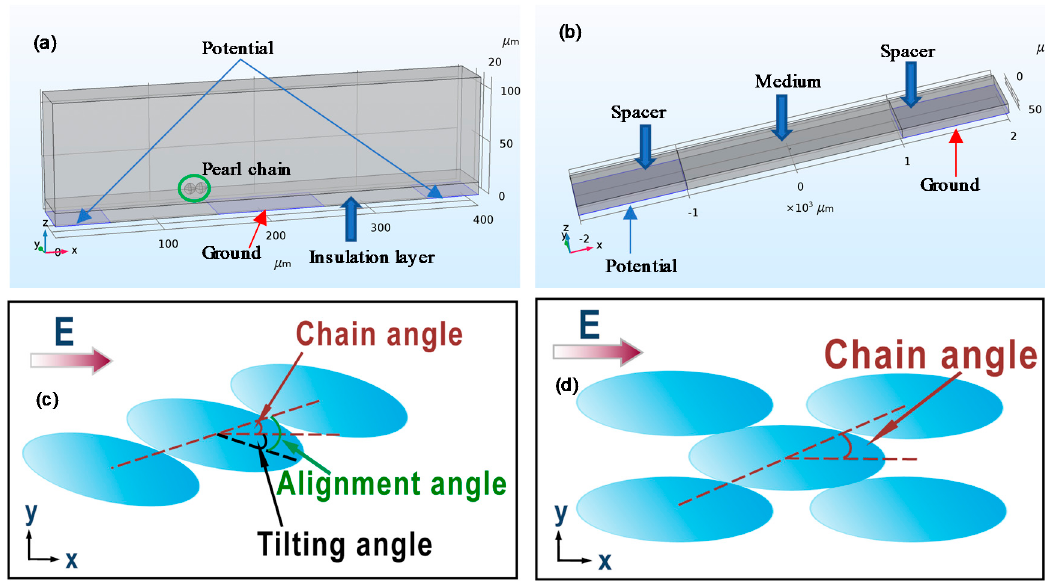
Figure 2. ( a ) Geometry of the 3D model for simulating the tumbling motion of pearl chain in a flow condition. ( b ) Geometry of the 3D model same as the experimental setup of Singh et al. [14] for simulating the alignment of ellipsoidal particles. ( c ) Illustration of ellipsoidal particle alignment in chain configuration. ( d ) Illustration of ellipsoidal particle alignment in stacked configuration.